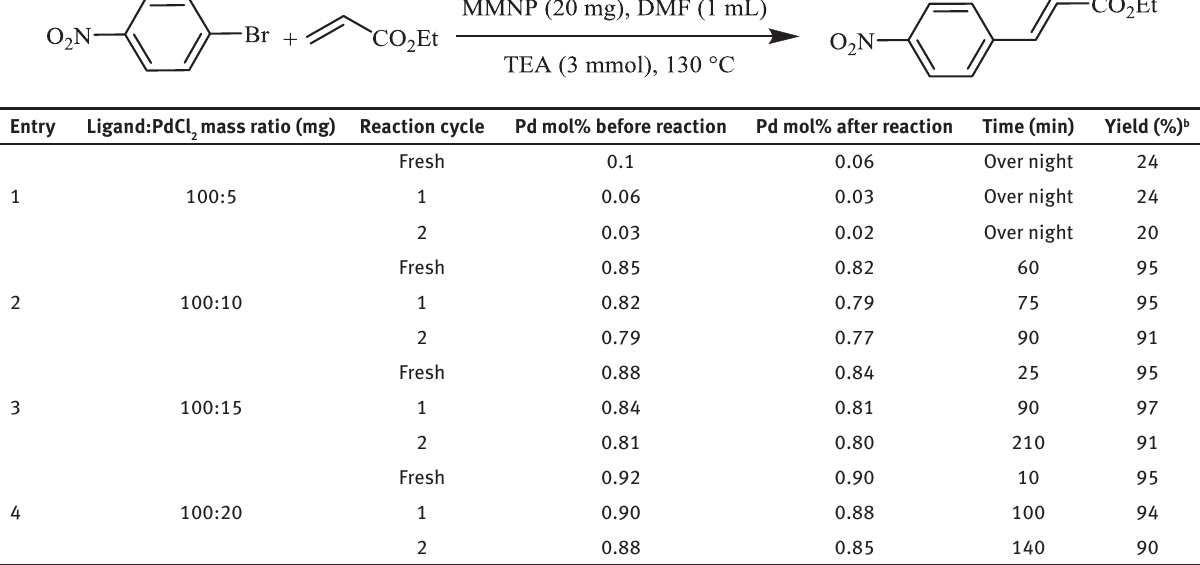
Table 3: Screening of various catalyst loading in the Heck reaction. a